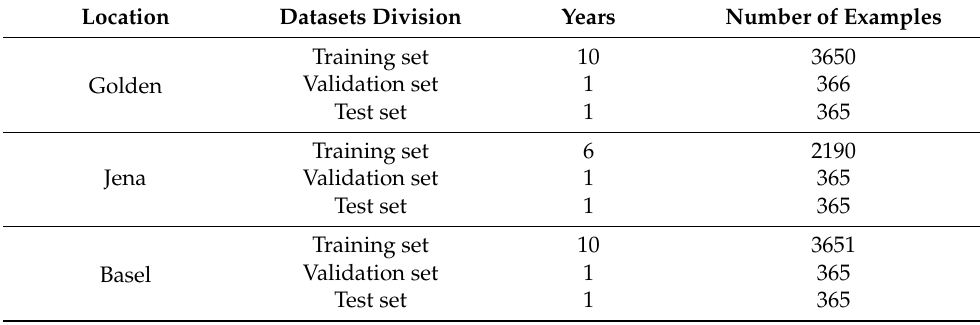
Table 2. Dataset distribution.